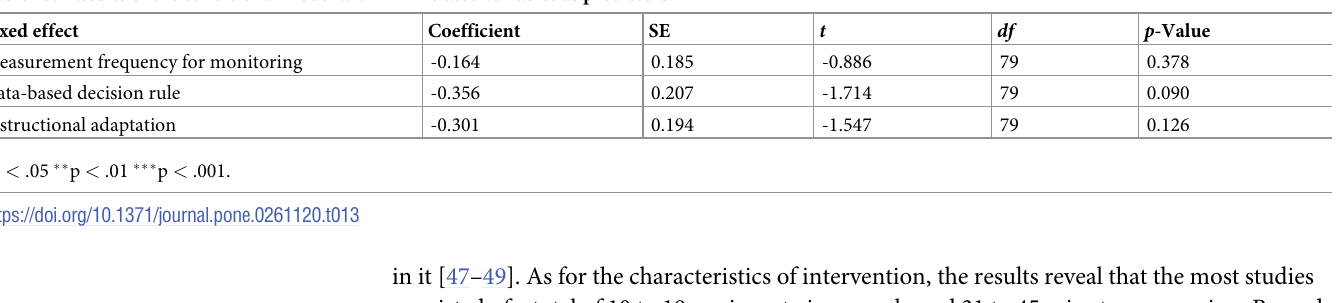
Table 13. Results of the conditional model with DBI-related variables as